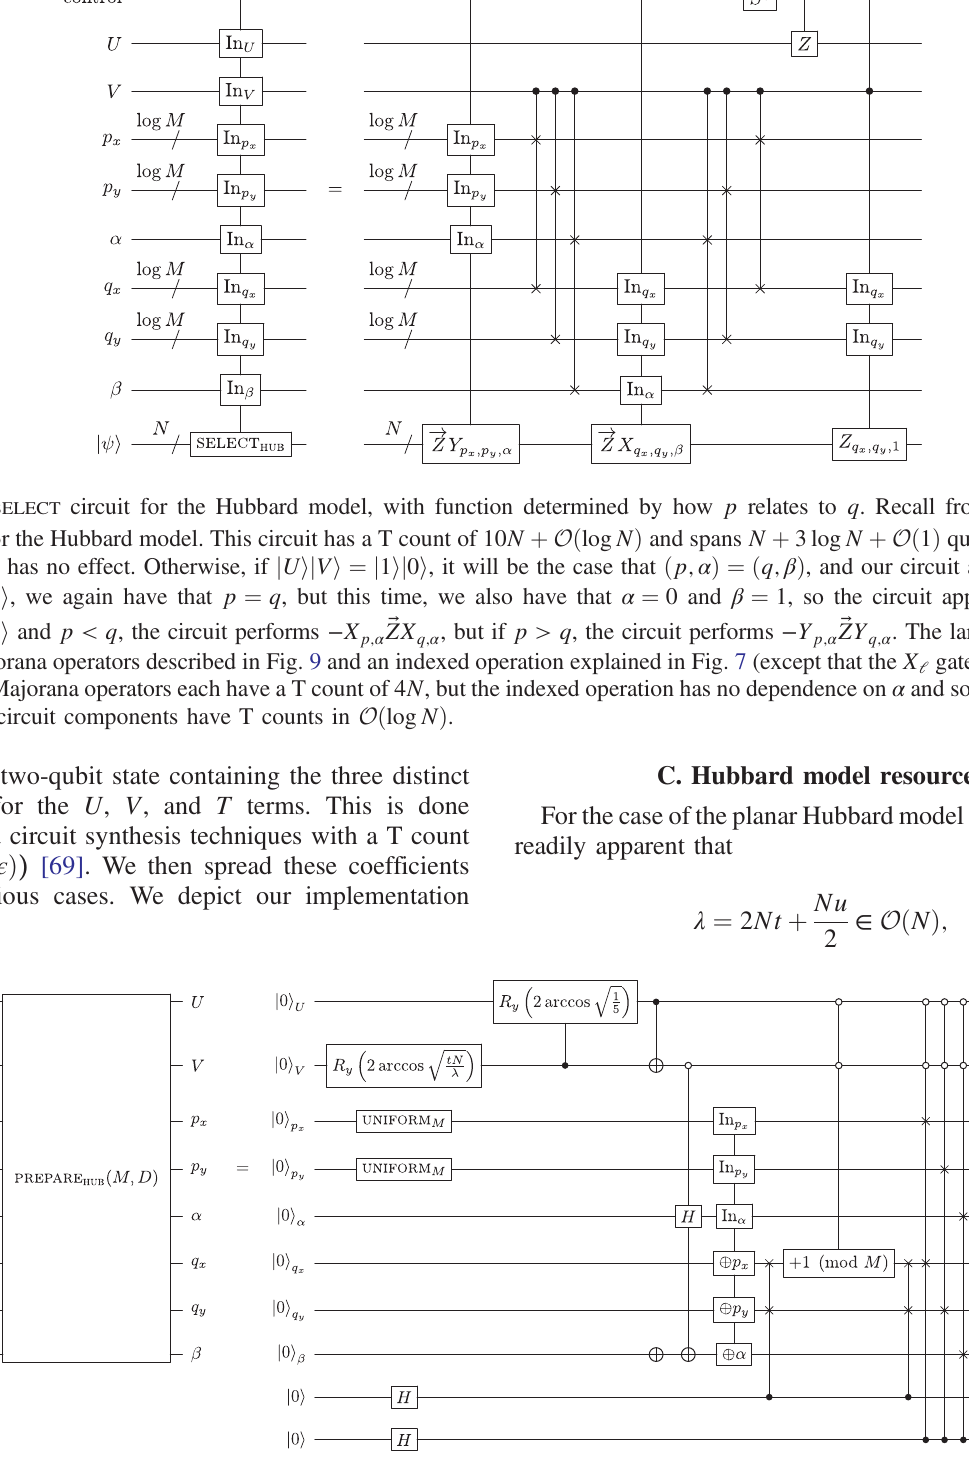
FIG. 20. PREPARE circuit with T count O ( log ð N= ϵ Þ ) . The R operations are used to prepare the three distinct LCU coefficients, ffiffiffiffiffiffiffiffiffiffi p ffiffiffiffiffiffiffiffiffiffiffiffiffiffiffiffiffi p ffiffiffiffiffiffiffiffiffiffiffiffiffiffiffiffiffi p y HUB tN= λ Nu= ð 4 λ Þ Nu= ð 8 λ Þ which, including multiplicity, are (for the 2 N T -type terms), (for the N ¼ 2 M 2 U -type terms), and (for the N= 2 ¼ M 2 V -type terms). We only specify the action of this circuit in the case where the inputs are all j 0 i . During the actual , p , and α qubits as well as execution, the effects of the SELECT operation will prevent PREPARE † from exactly uncomputing the U , V , p x y the bottom two ancilla qubits. This is the expected behavior, and it is required that the potentially not-uncomputed qubits be kept and used as inputs for the next PREPARE HUB